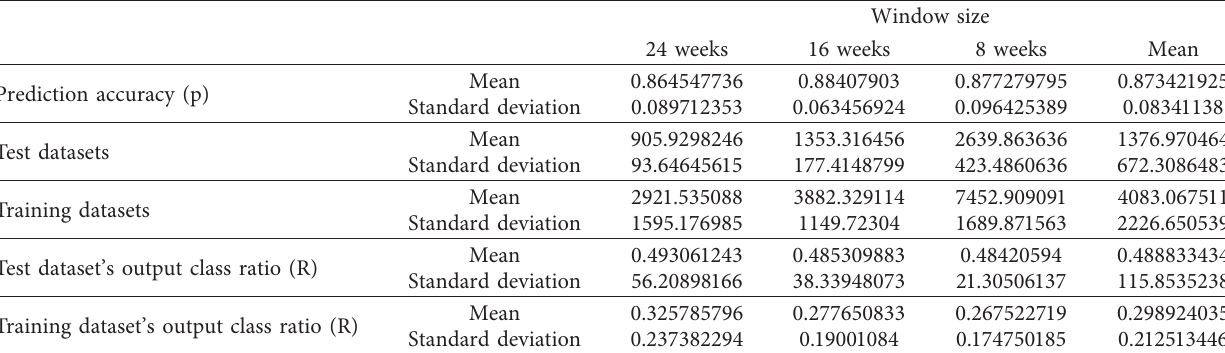
Table 3: Aggregated statistics of the 237 iterations which produced the highest reliability accuracy metrics. Source: own